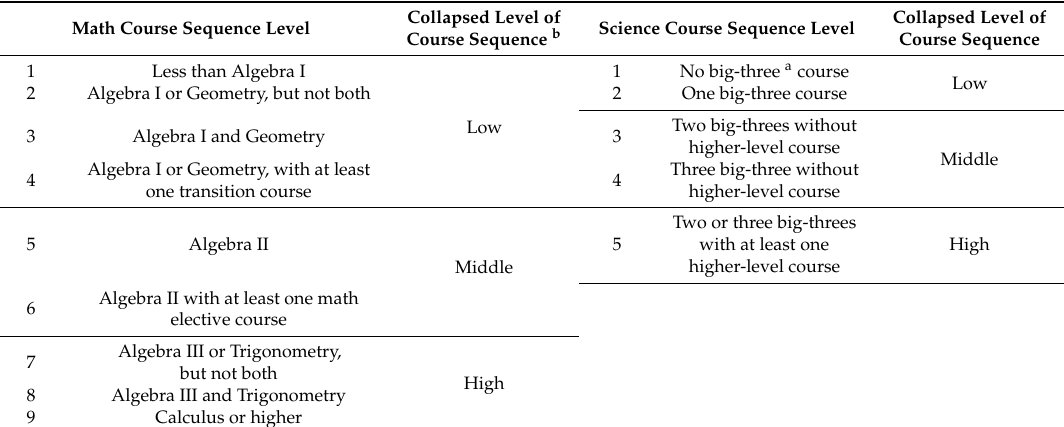
Table 5. Constructing measures of course taking using information from the cumulative sequence of courses